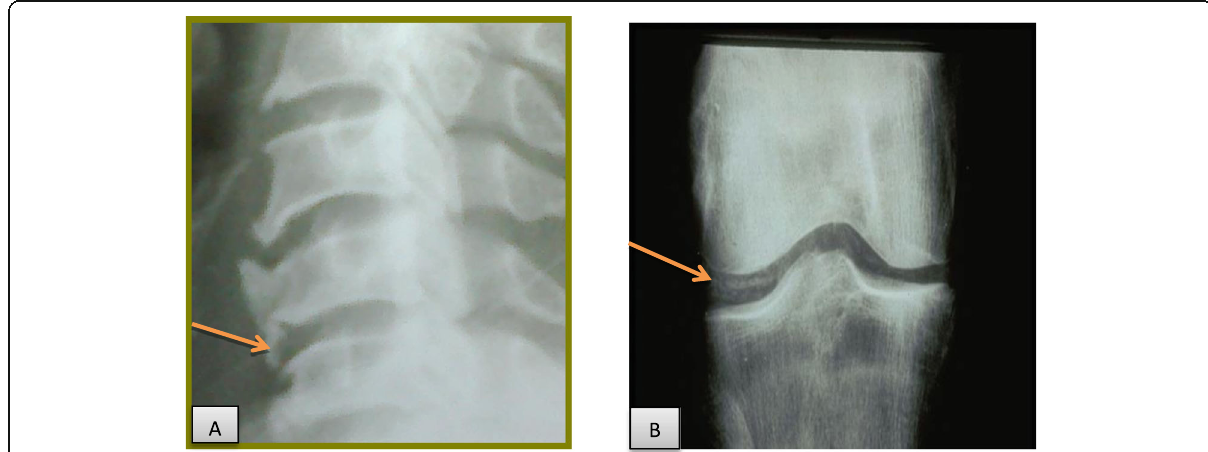
Fig. 1 a Plain X-ray, lateral view of on cervical spine shows anterior longitudinal ligament calcification (arrow). b Plain radiography of the knee joint showing chondrocalcinosis (arrow)